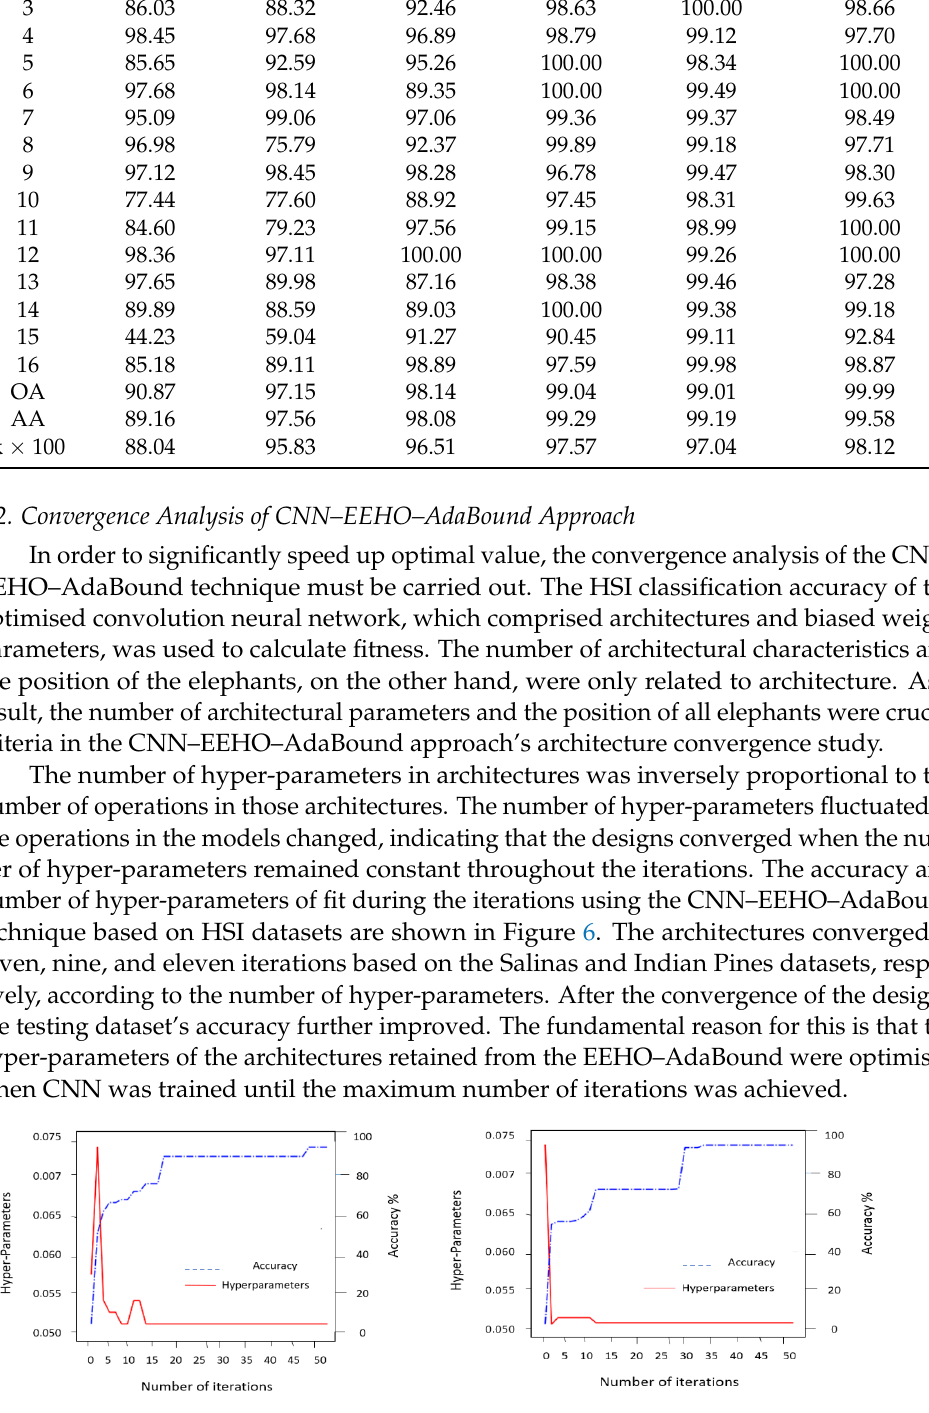
Figure 6. The training convergence performance